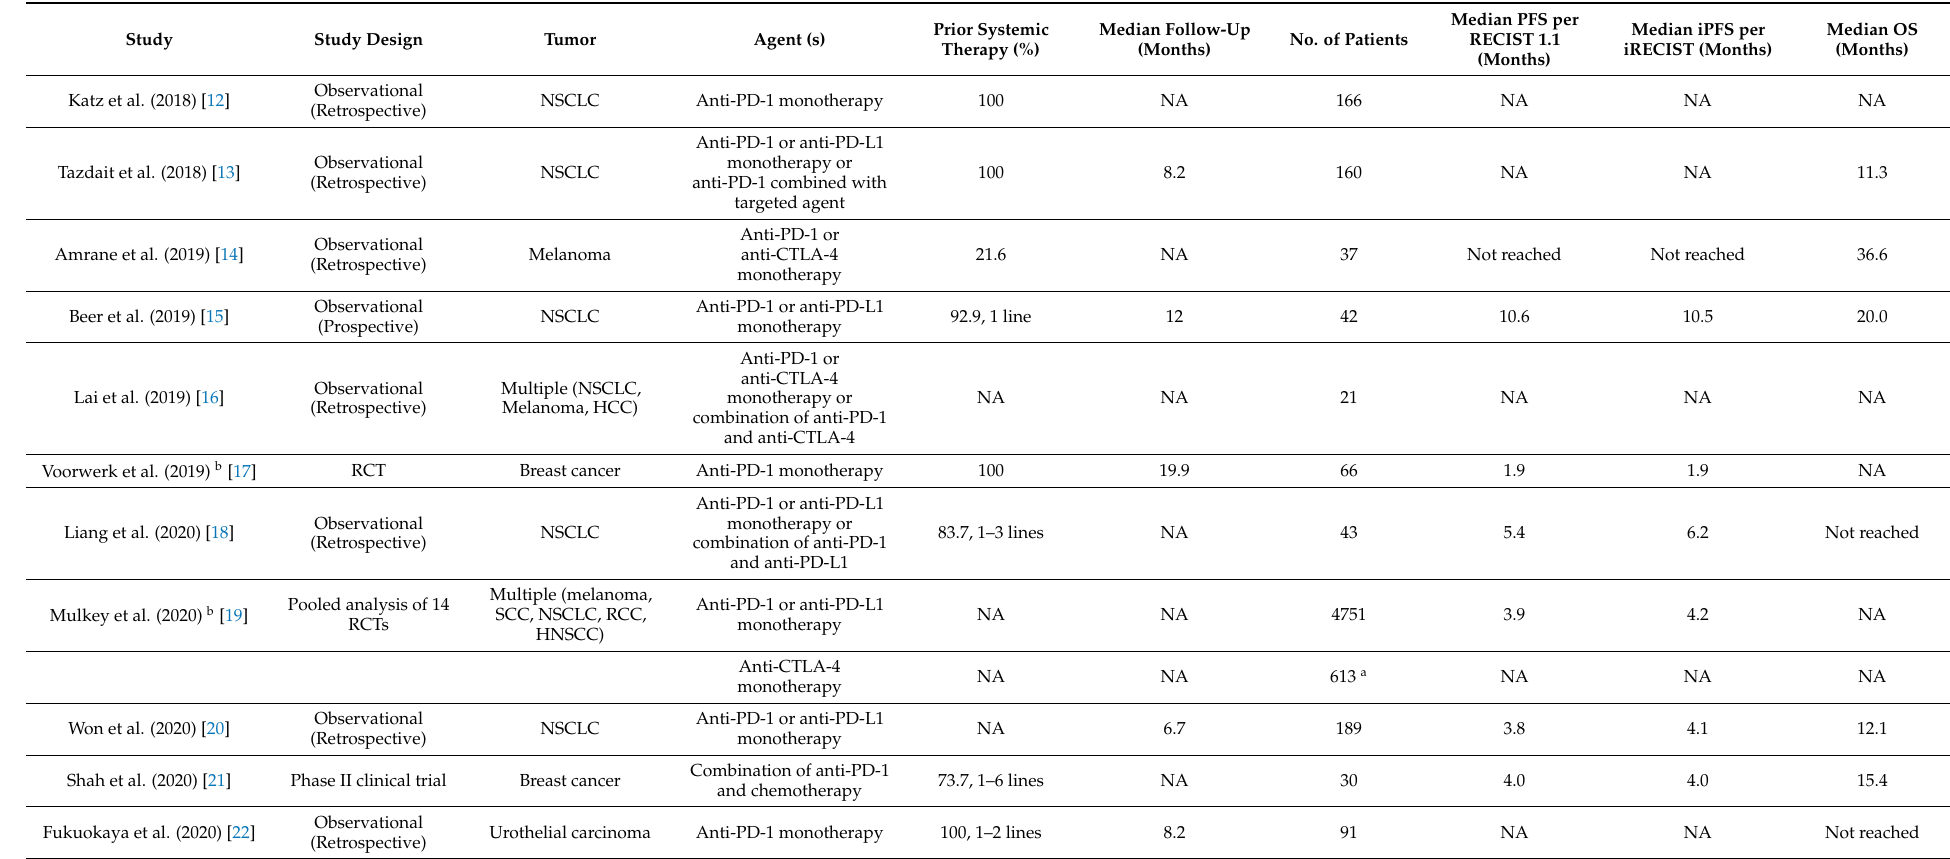
Table 1. Characteristics of the studies included in the